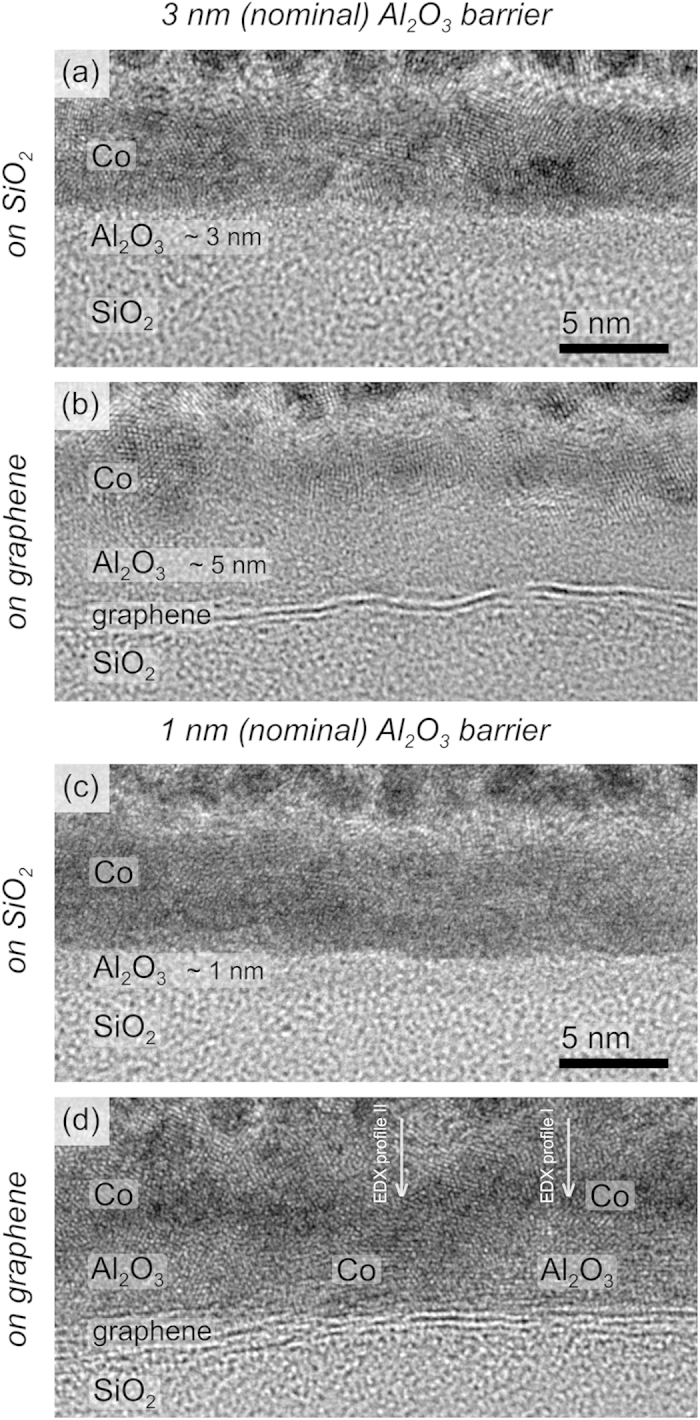
TEM cross-sectional images of samples with different Al2O3 barrier thicknesses, 3-nm-thick (nominal) barrier on (a) SiO2 and (b) graphene, 1-nm-thick (nominal) barrier on (c) SiO2 and (d) graphene.